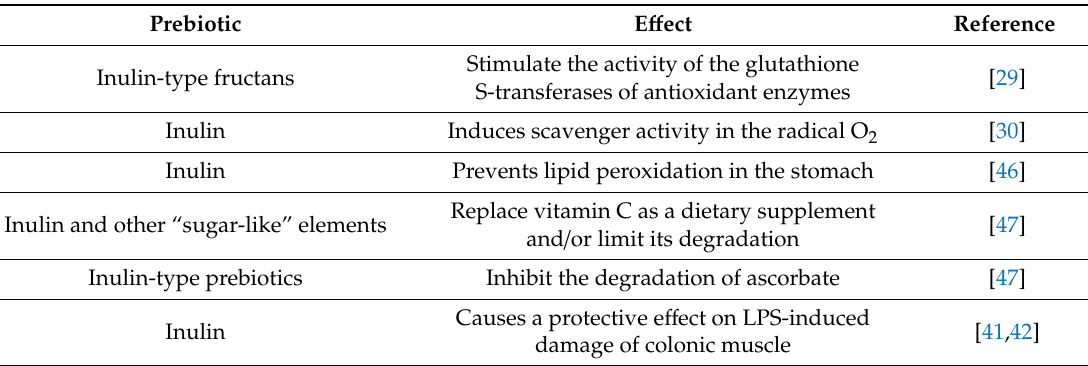
Table 1. In vitro e ff ects of inulin-type